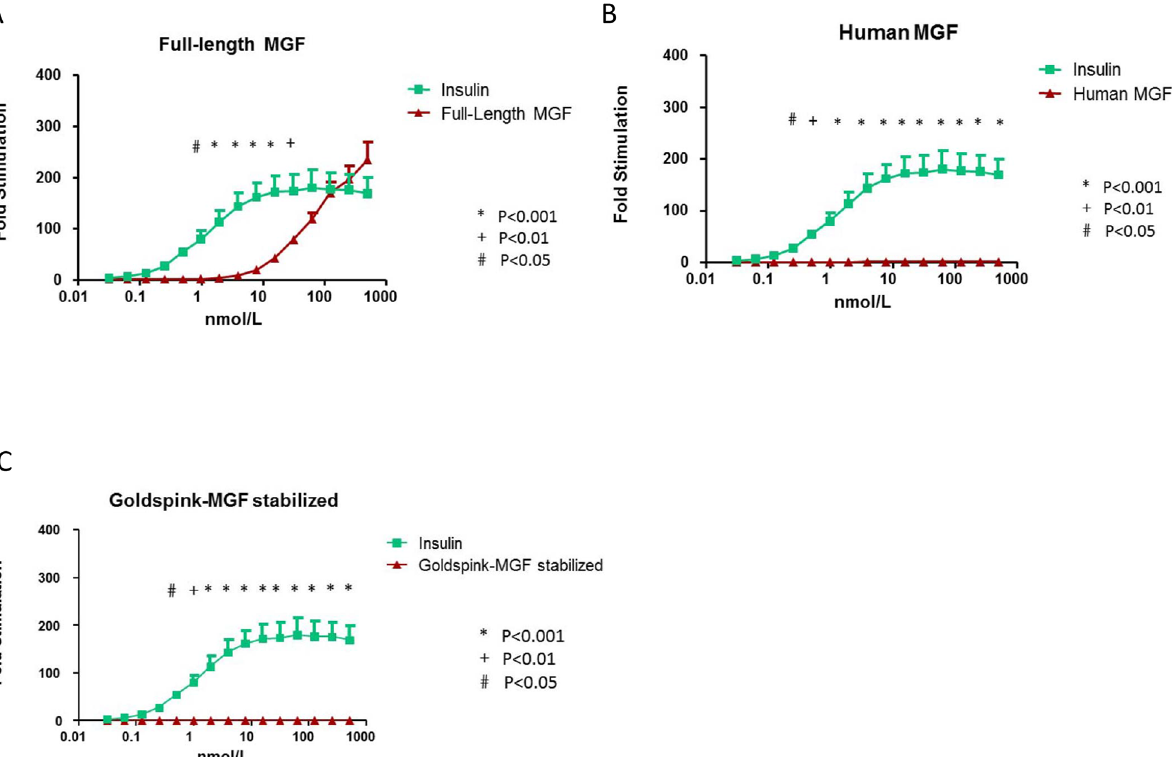
Fig 3. Stimulatory activity of the insulin receptor-A (IR-A). A : Comparison of full-length MGF (red points and line) and insulin (green points and line). B: Comparison of Human MGF (red points and line) and insulin) (green points and line). C: Comparison of Goldspink-MGF (red points and line) and insulin (green points and line). Dose-response curves ranged from 0.03125 nmol/L to 500 nmol/L. For bioactivity measurements means ± SEM and signal-to-noise ratios are presented. A-C : Each point represents the mean value ± SEM of at least three independent experiments. P = P-value when comparing overall differences in fold stimulation between two